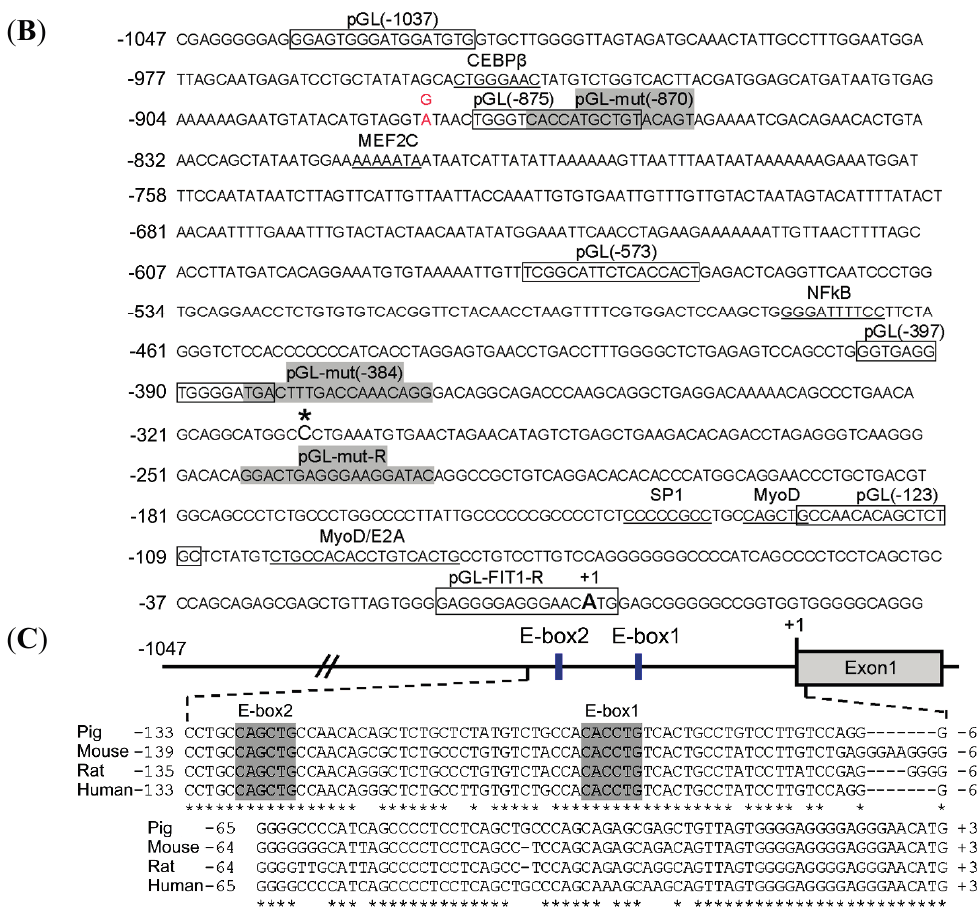
Figure 1. Sequence analysis of the 5 ′ -flanking region of porcine FIT1 gene. ( A ) Schematic of the region surrounding FIT1 gene on the chromosome 7 of the pig genome (SSC7) as well as the transcription factor binding sites in the 5 ′ -flanking region of FIT1 gene. Top : blue bars represent gene positions. PSME2 , proteasome activator complex subunit 2 gene; PSME1 , proteasome activator complex subunit 1 gene; PCK2 , phosphoenolpyruvate carboxykinase 2 (mitochondrial) gene; Bottom : The transcription factors are indicated in red color, with their individual binding sites in blue bars. The translation initiation site is designated as +1. CEBP β , CCAAT/enhancer-binding protein β ; MEF2C, myocyte-specific enhancer factor 2C; NF κ B, nuclear factor κβ ; SP1, specificity protein 1; MyoD1, myogenic differentiation 1; E2A, E-protein transcription factors E12 and E47; ( B ) nucleotide sequences of the 5 ′ -flanking region of porcine FIT1 gene. The transcription initiation site is indicated with an asterisk; putative transcription factor binding sites are underlined with names indicated above the line. The primers for the promoter deletion amplification are boxed and the primers for the mutated constructs are highlighted in gray color. The base in red color denotes the polymorphic site between Large White pig and Meishan pig; ( C ) sequence alignment of the proximal promoter of FIT1 gene across pig, mouse, rat and human. Two highly conserved MyoD binding sites (E-box1: CACCTG and E-box2: CAGCTG) among these species are indicated in gray color with names above the sequence and their relative positions in the promoter are shown in blue bars. Asterisk: conservative bases across these